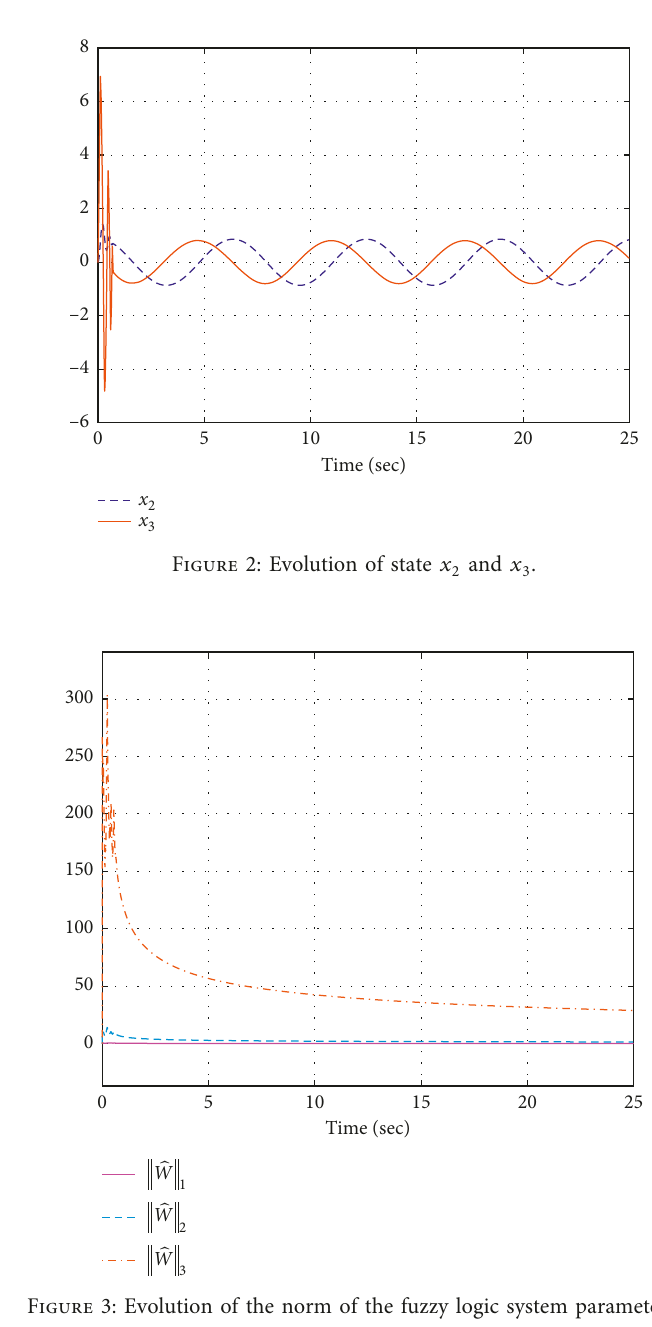
Figure 3: Evolution of the norm of the fuzzy logic system